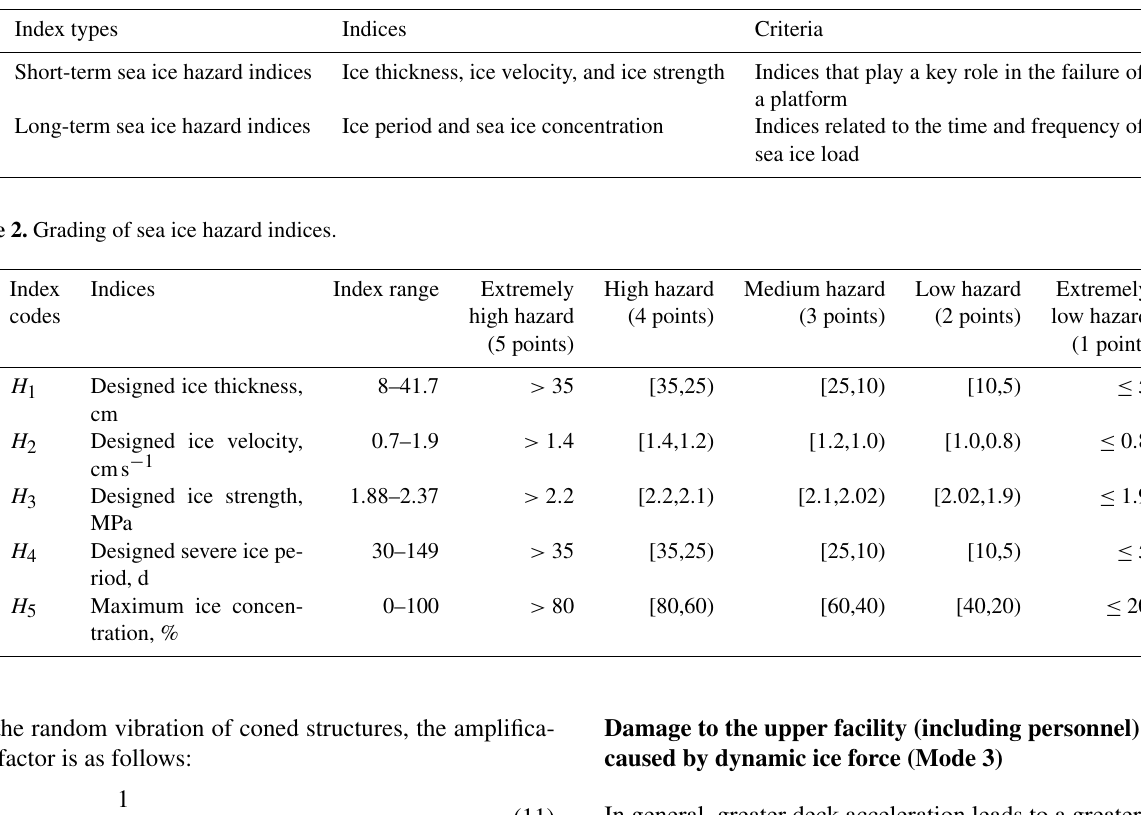
Table 1. Sea ice hazard indices.